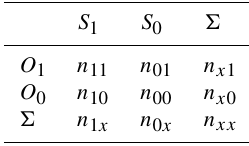
Table 4. Two-by-two contingency table for the comparison of bi- nary snow cover observations and simulations (after Zappa (2008)). O and S denote observations and simulations, while the subscripts 0 and 1 correspond to snow-free and snow-covered situations, re-